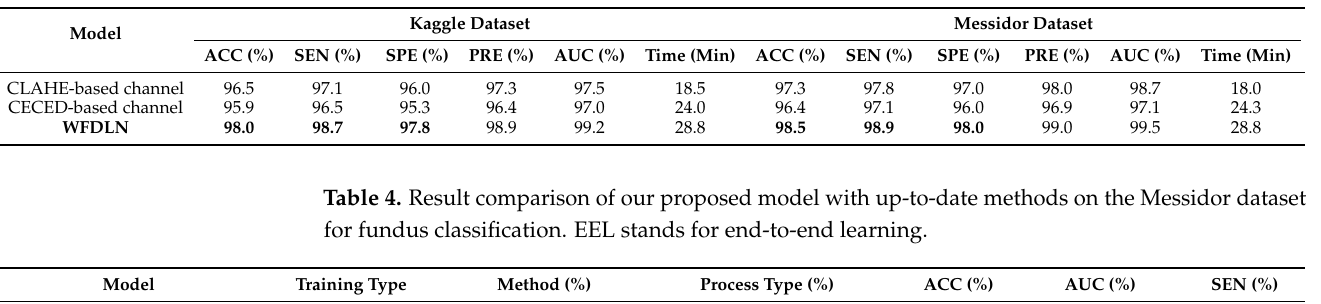
Table 3. Comparison of our proposed model with single channels.